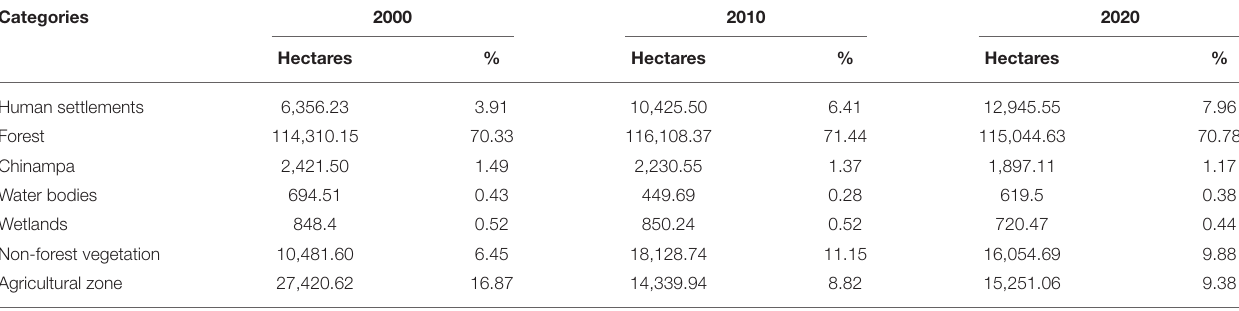
TABLE 5 | The conservation zone: land use changes by main categories,